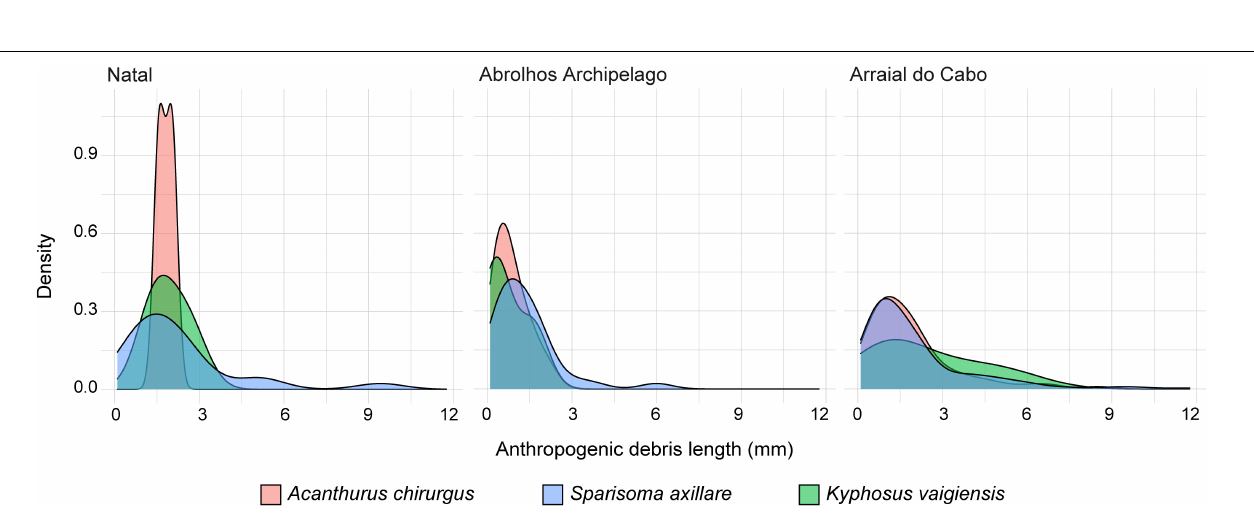
Frontiers in Marine Science |